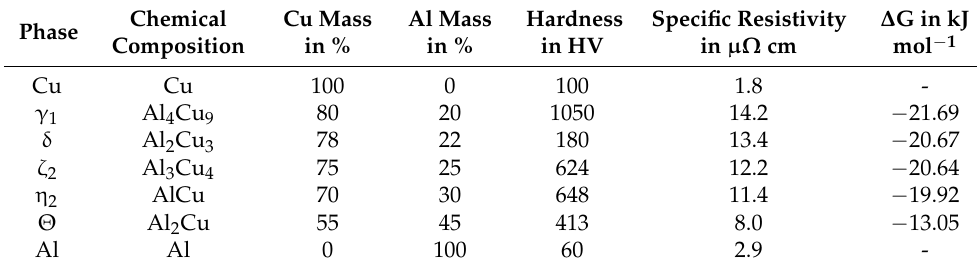
Table 1. Intermetallic phases of copper and aluminum and their physical properties